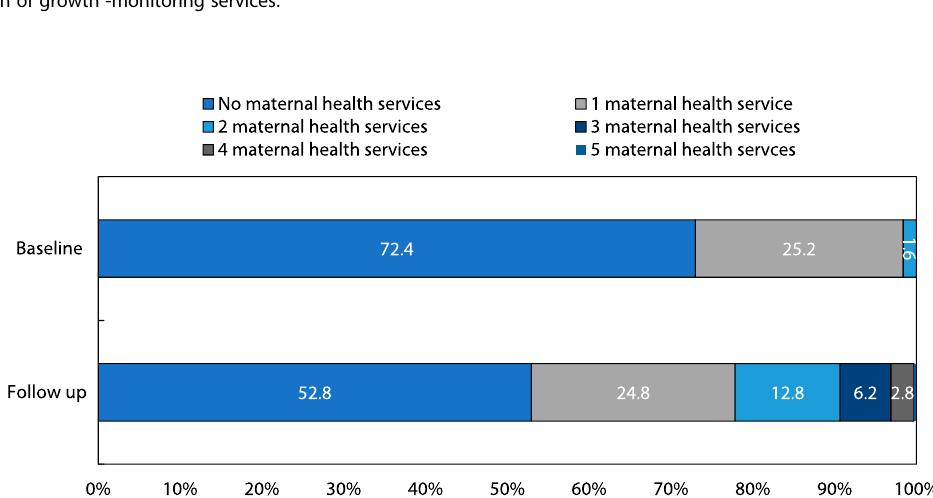
Figure 2: Provision of growth -monitoring services.